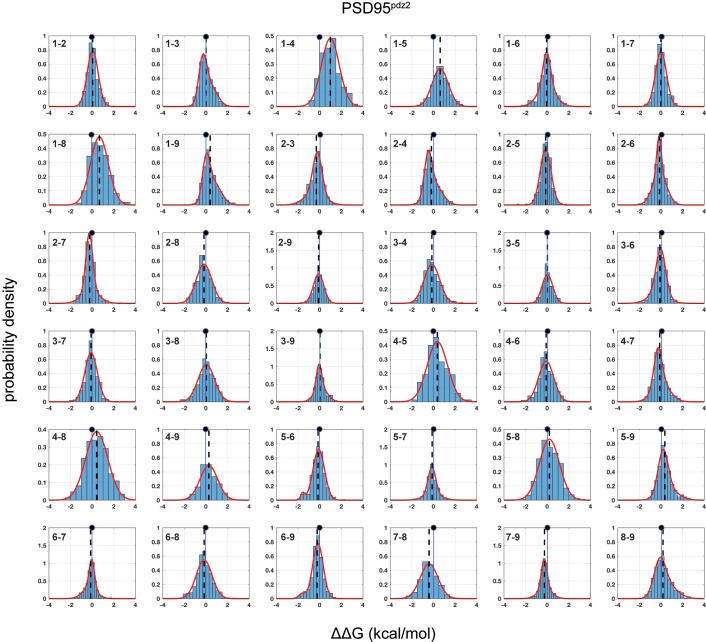
Distributions of double mutant cycles for each α2 helix position pair (numbering as in Figure 1C) for PSD95pdz2.As in Figures 2–3, distributions are fit to single or double Gaussians, using the Bayes Information Criterion to choose the model. The position of zero coupling is indicated by the solid line and circle above, and the population weighted mean is represented in dashed lines.